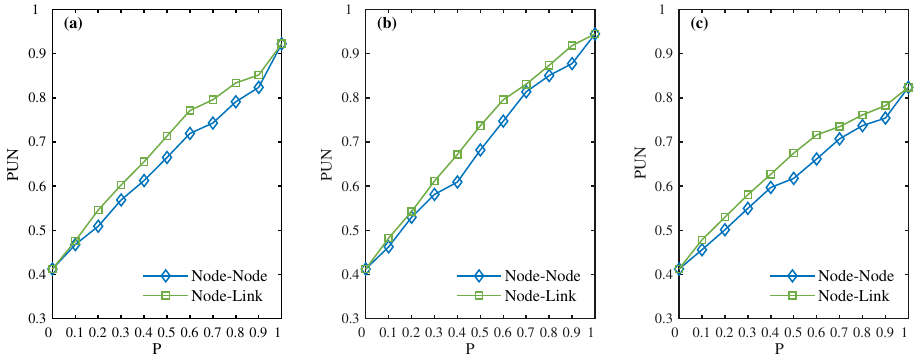
Figure 4. Robustness of CPS changes as a function of failure propagation P under two propagation objects. ( a ) Assortative Coupling; ( b ) Disassortative Coupling; ( c ) Random